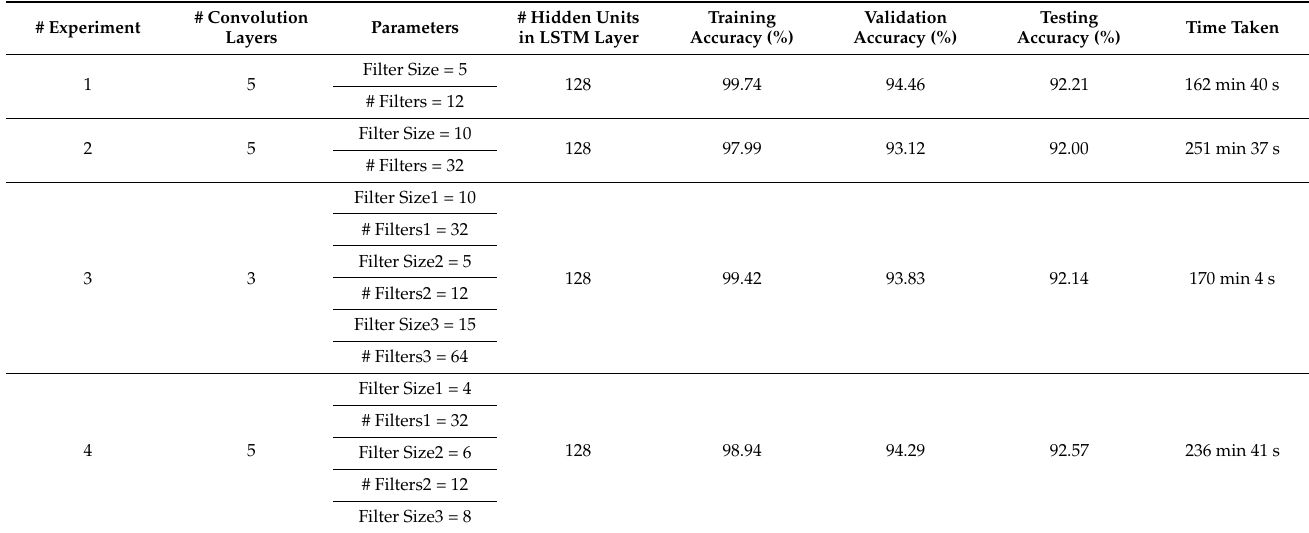
Table 4. Snapshot of selected experiment configurations and